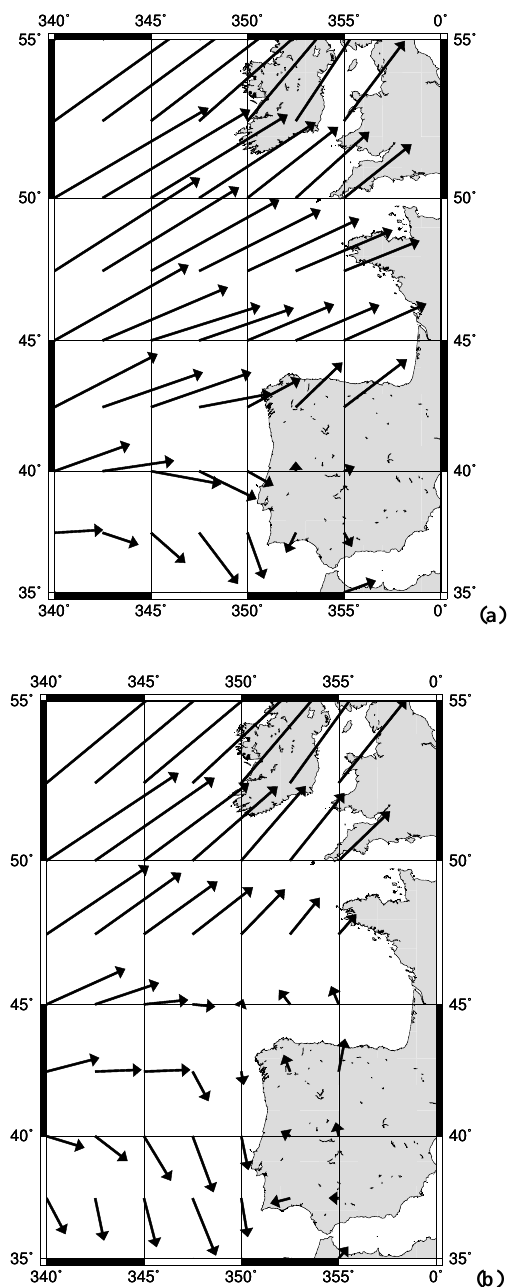
Fig. 7. Dominant winds – Summer. (a) Long-term average 1948– 2001, (b)